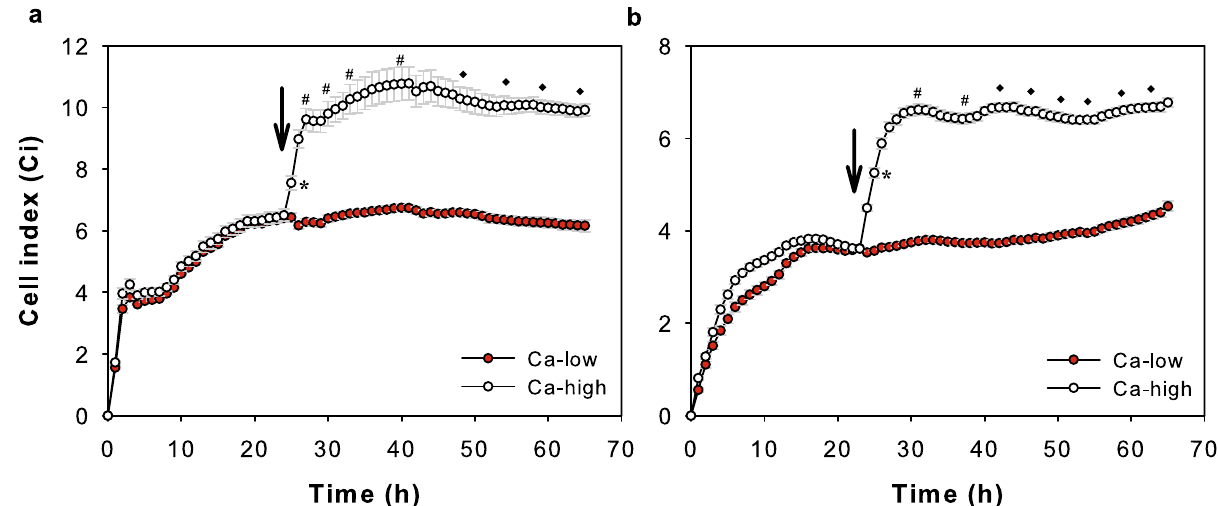
Figure 1. High Ca 2+ concentration leads to elevated Ci values of NHEK and HPV-KER cultures. Confluent NHEK ( a ) and HPV-KER ( b ) monolayer cultures were incubated in standard KSFM media. After 24 h (marked with an arrow), the extracellular Ca 2+ concentration was raised, leading to marked Ci increases. Representative image of three independent experiments. Data points are measured in every 4 h. Time points are the mean ± SEM. Statistical analysis with Student’s t-test, *p < 0.05, # p < 0.005, ♦ p <